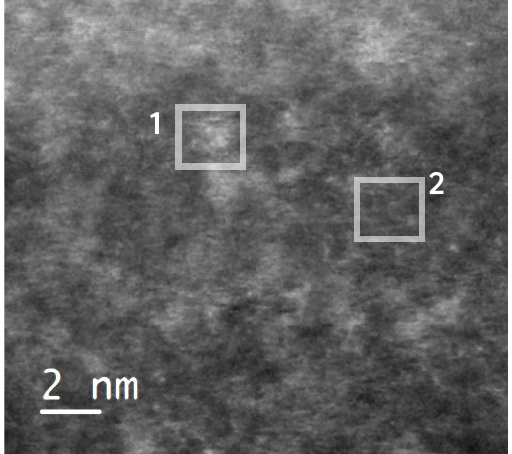
Figure 2. High-angle annular dark field (HAADF) micrograph of a 05FeKIL-2 silica particle, where one to two nm sized areas with brighter contrast could be seen. Squares indicate the positions where EELS spectra were